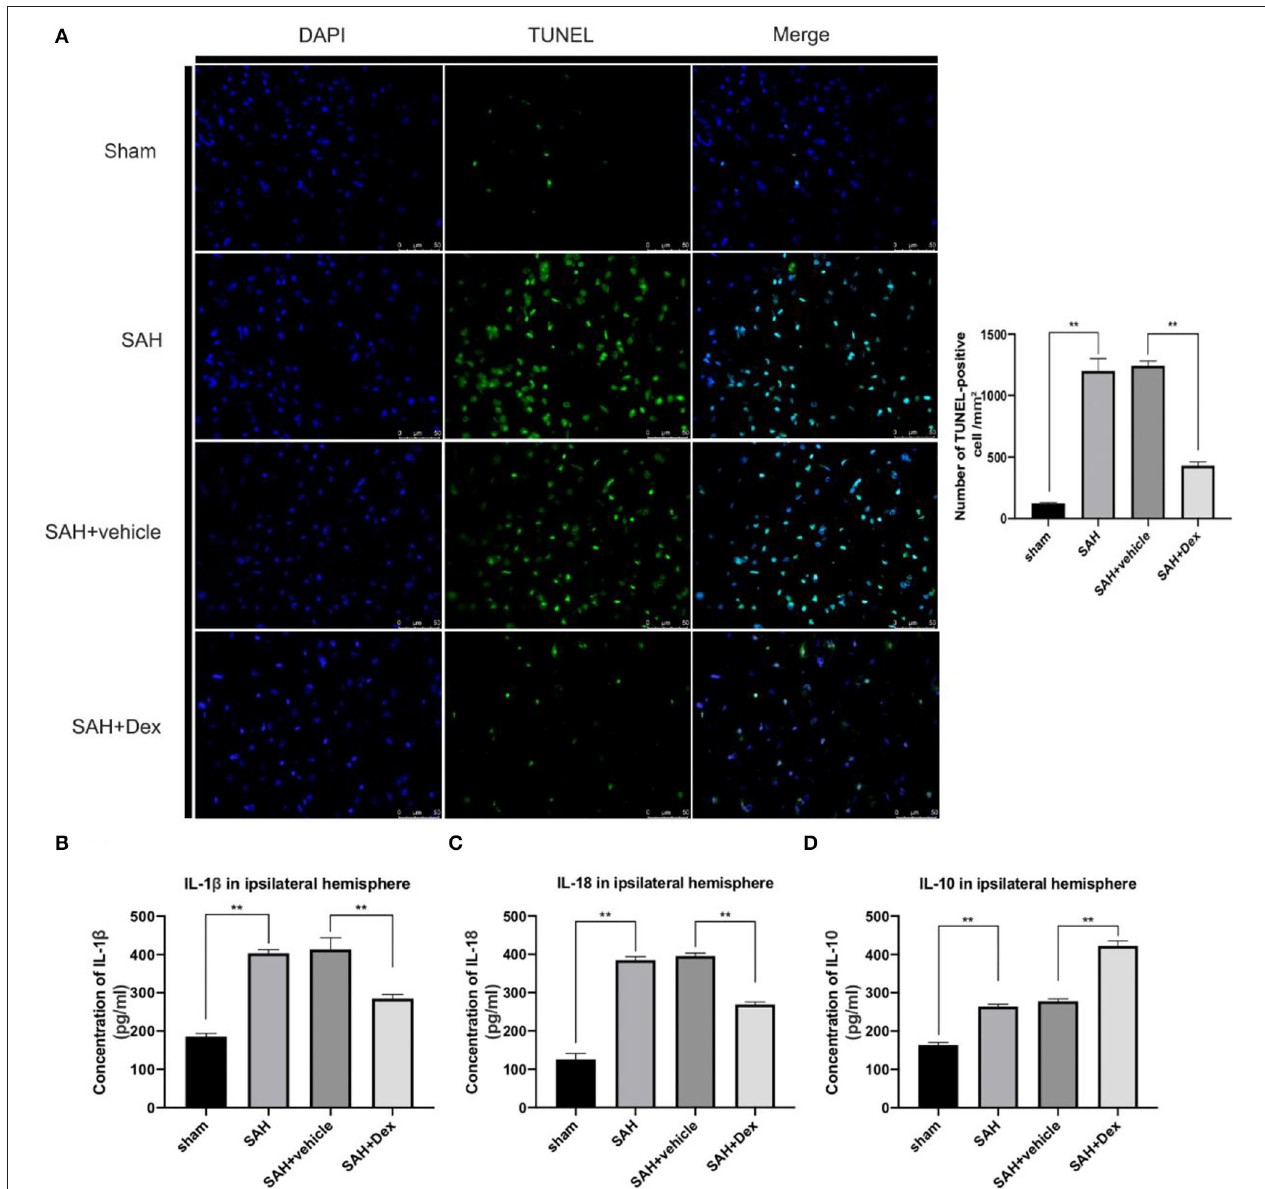
FIGURE 7 | Effects of Dex on cell apoptosis and inflammatory factors production. (A) Representative microphotographs of TUNEL-positive cells in the ipsilateral cortex at 24h after SAH. (B–D) ELISA results indicating the levels of the proinflammatory factors IL-1 β , and IL-18 and the anti-inflammatory factor IL-10 in the ipsilateral cerebral tissue at 24h post-SAH; n = 6 in each group. Data are expressed as the mean ± SD. ** p < 0.01. Scale bar = 50 µ